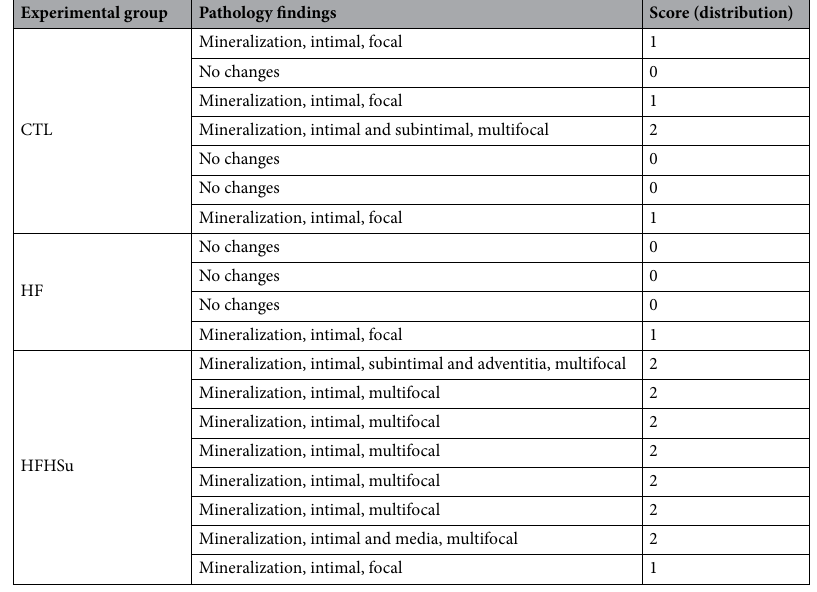
Table 2. Effect of hypercaloric diets, high-fat (HF) and high fat-high sucrose (HFHSu), on pulmonary artery mineralization. Vascular mineralization was classified using a scoring system, determined based on calcification in arterial cross section according to a 4-tier severity scale: 0, no calcification; 1, focal calcification spots; 2, partial calcification covering 20–80% of the arterial circumference; and 3, circumferential